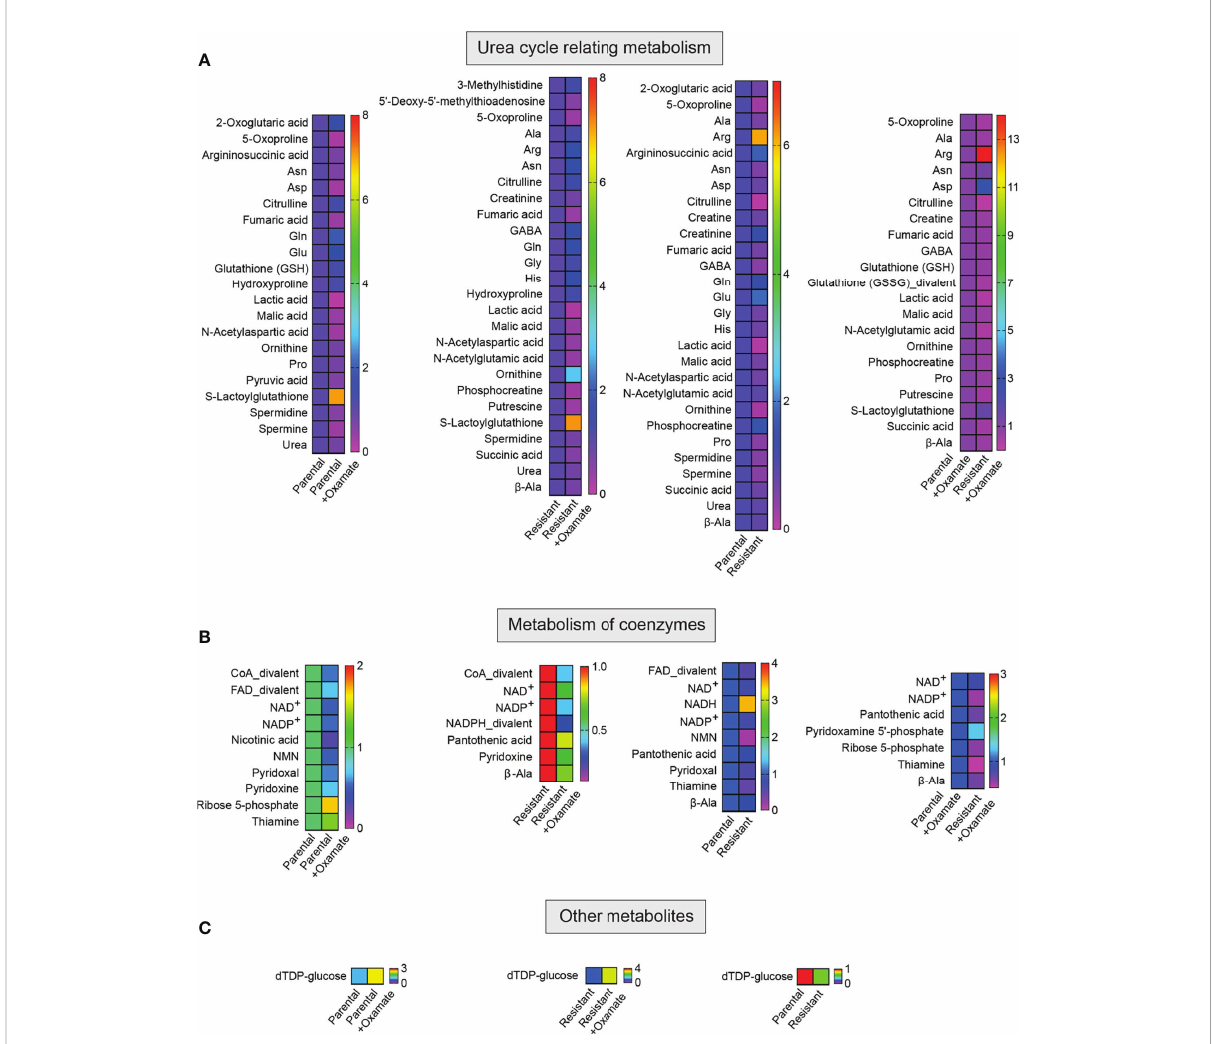
FIGURE 7 Metabolites associated with the metabolism of urea and coenzymes and other metabolites in parental and oxamate-resistant cells treated with or without sodium oxamate. (A – C) Changes in the indicated metabolites generated during the metabolism of urea and coenzymes and other metabolites under the indicated